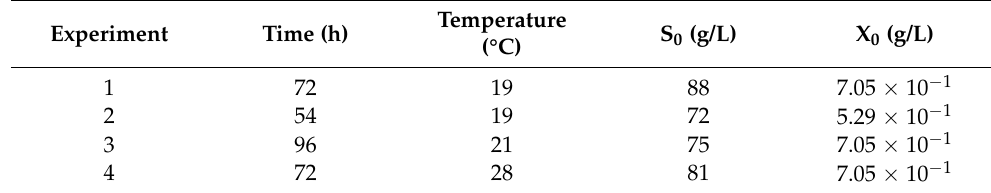
Table 2. Operating conditions of each fermentation batch: duration, temperature, and initial sugar and biomass